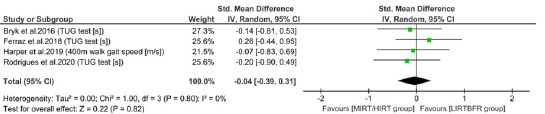
Fig 5. Forest plot of the comparison between LIRTBFR, MIRT and HIRT on functionality assessed by tests with patterns similar to walking (n = 4 studies). LIRTBFR: Low intensity resistance training combined with blood flow restriction; MIRT: Moderate intensity resistance training; HIRT: High intensity resistance training; TUG test: Time Up and Go test; [s]: seconds; [m/s]: meters per seconds; I 2 : Heterogeneity of studies; SD: standard deviation; MD: mean difference; SMD: standardized mean difference; 95% CI: 95% confidence interval; IV: inverse variance; Random: random effects model.